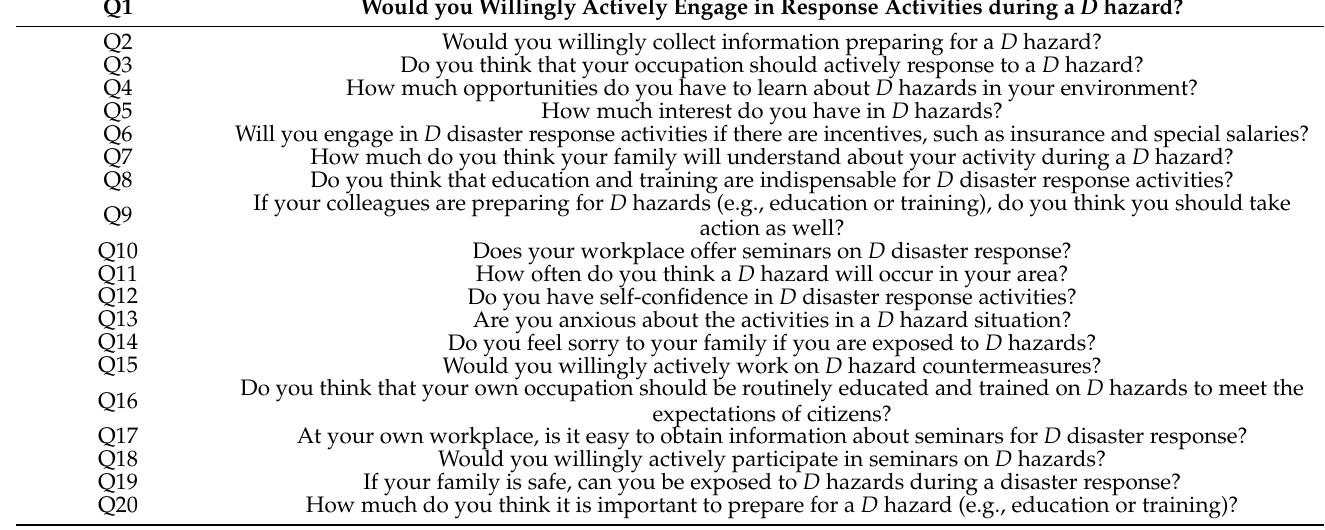
Table 2. Questionnaire